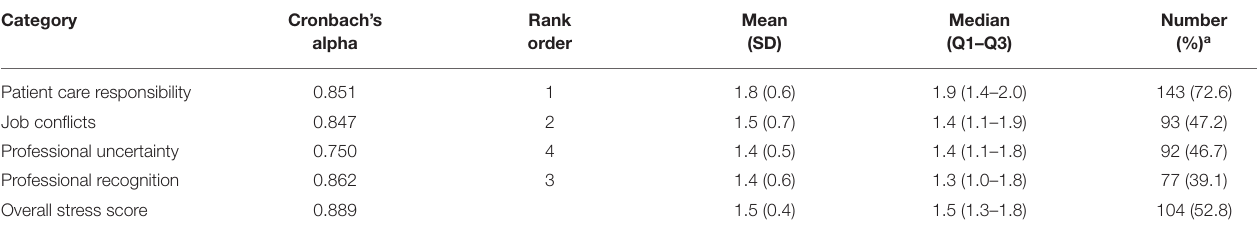
TABLE 2 | Average stress score of each subdomain and overall job stress domain.